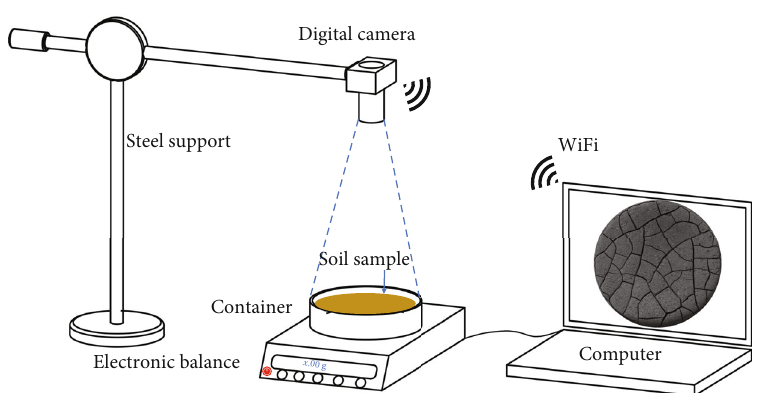
Figure 4: Schematic of automatic weighing and photographing system.